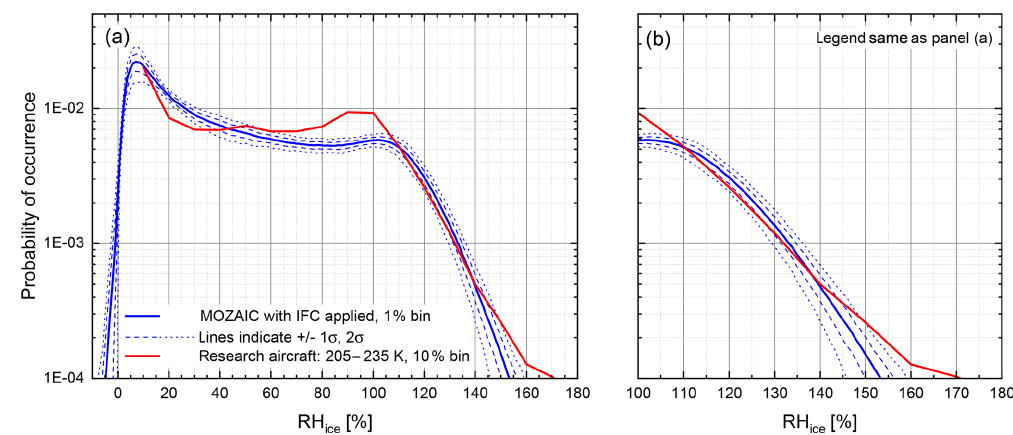
Figure 5. Averaged probability density functions of RH ice for the entire MOZAIC period from 1995 to 2010 with the in-flight calibration method applied (blue lines) and respective RH ice PDF from 250 research aircraft flights collected in the Jülich in situ airborne database (Krämer et al.,